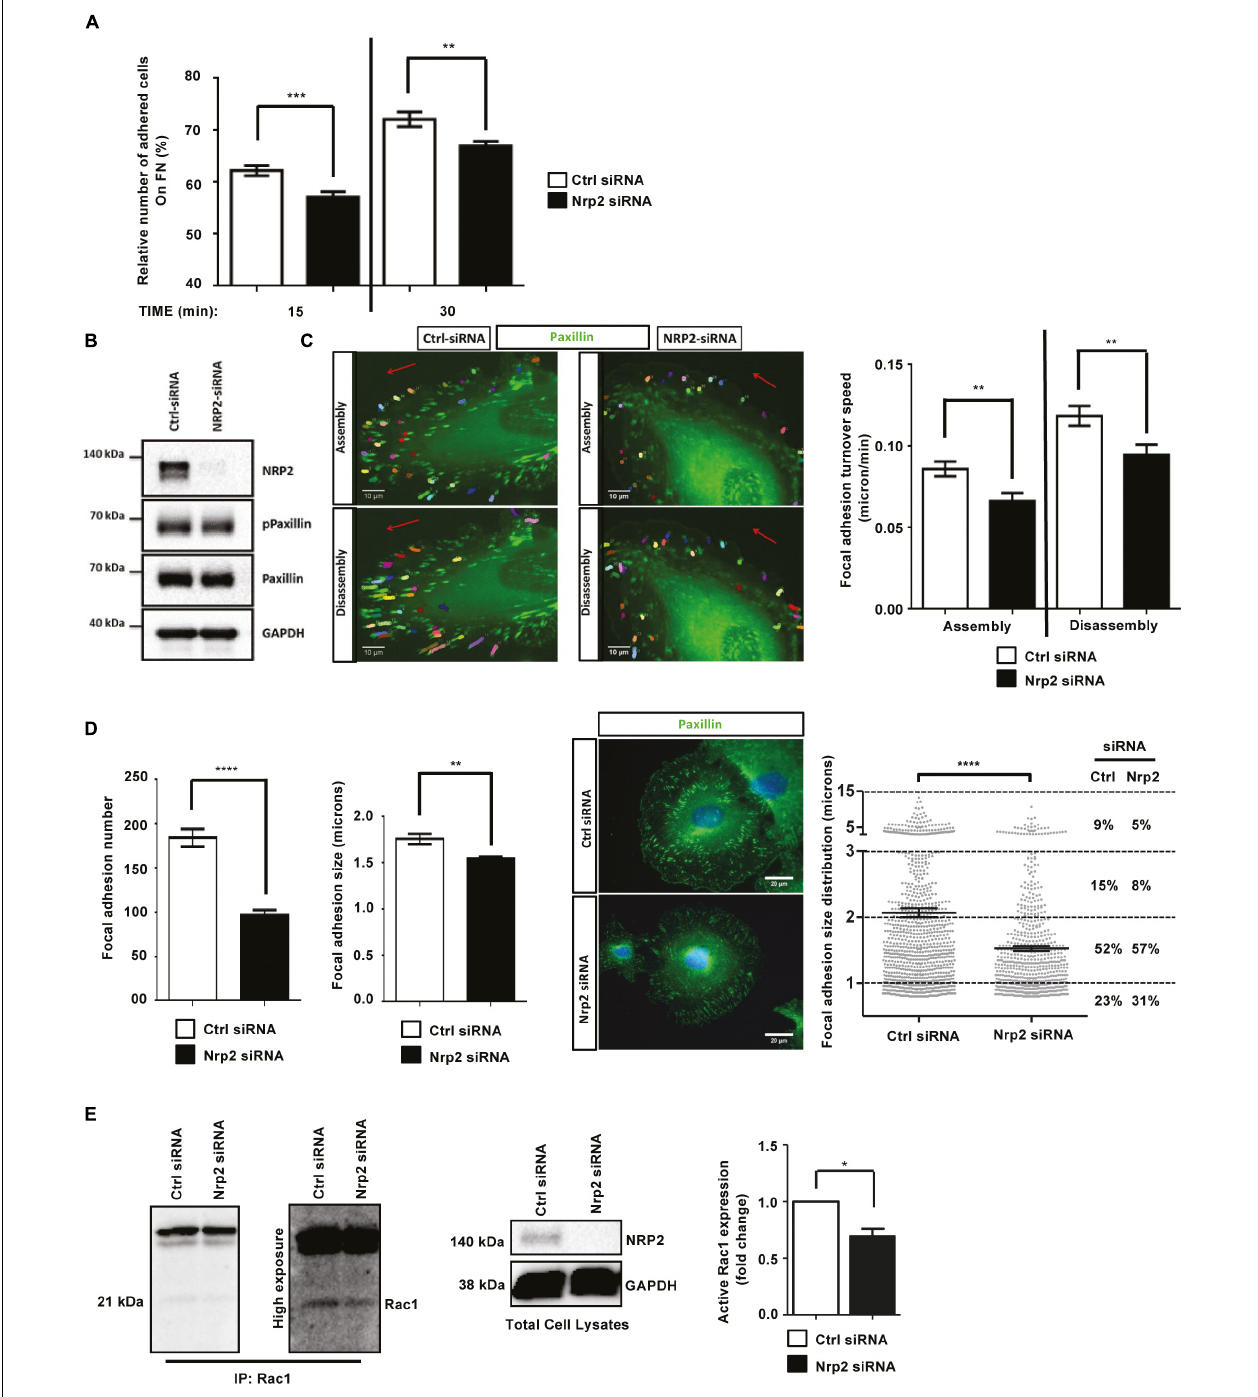
FIGURE 2 | Depletion of NRP2 in ECs disrupts migration and adhesion to FN matrices by affecting Rac1 activation (A ): siRNA-transfected ECs were seeded onto FN coated 96-well plates pre-blocked with 5% bovine serum albumin (BSA), and incubated for either 15 or 30 min at 37 ◦ C and 5% CO 2 . ECs were subsequently fixed in 4% PFA and stained with methylene blue. Absorbance was read at 630 nm. Data was normalized to the relative number of the total cells seeded in a 3-h incubation control plate. N = 3 independent experiments, ** P < 0.01, *** P < 0.001. Asterisks indicate statistical significance from unpaired two-tailed t -tests. (B) siRNA-transfected ECs were plated onto FN and incubated for 48 h at 37 ◦ C and 5% CO 2 . EC lysates were immunoblotted using antibodies to NRP2, phospho-paxillin, paxillin and GAPDH. (C) siRNA-transfected ECs were double transfected with a GFP paxillin construct, seeded onto FN and incubated for 48 h at 37 ◦ C and 5% CO 2 . ECs were fixed in a Ludin chamber and live imaged at 37 ◦ C and 5% CO 2 using an inverted Axiovert microscope in which an individual